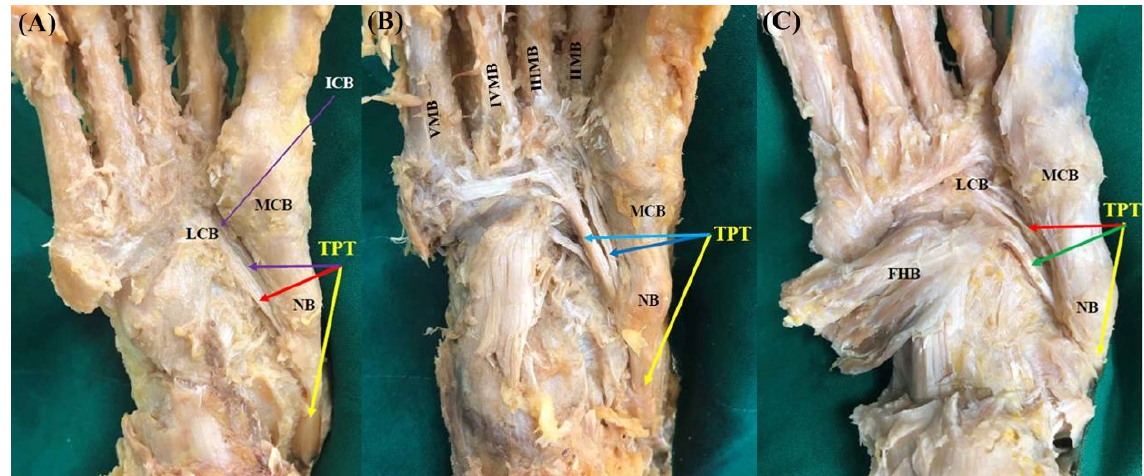
tarsal bones; FHB, flexor hallucis brevis. FHB, flexor hallucis brevis.